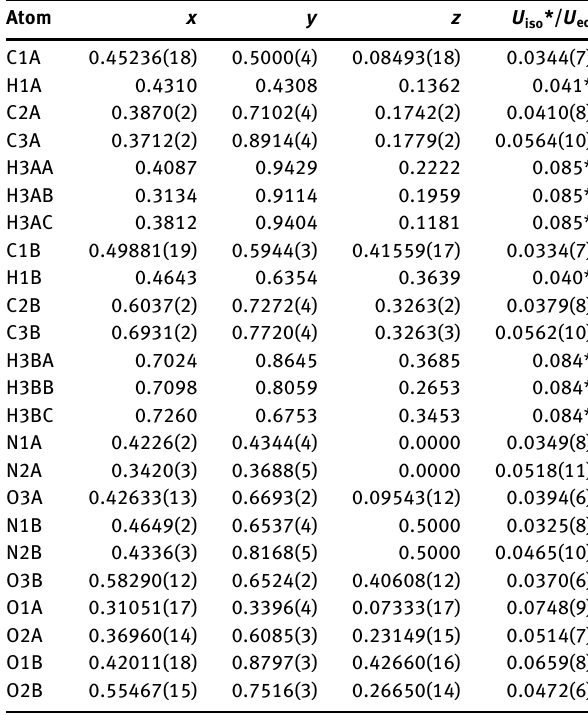
Table 2: Fractional atomic coordinates and isotropic or equivalent isotropic displacement parameters (Å 2